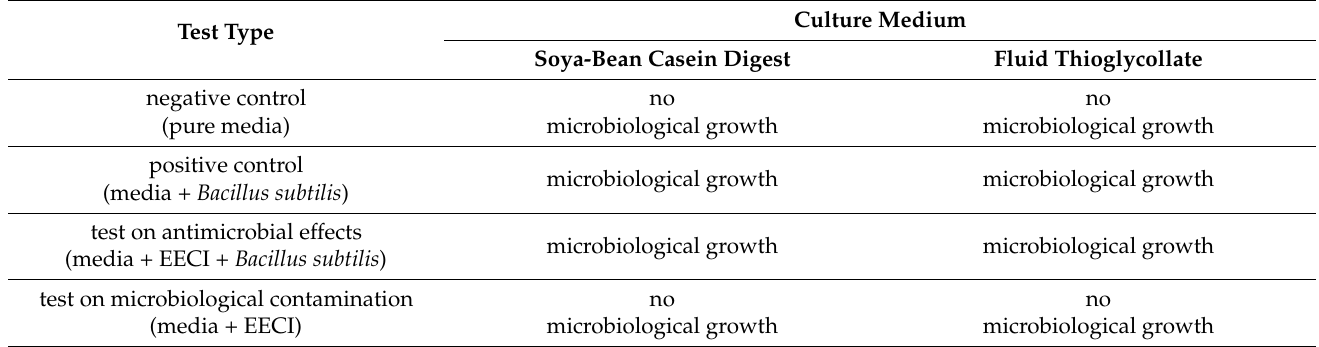
Table 2. Results of the pre-test on microbiological contamination of the 3D-printed EECI after 14 days of incubation in culture medium. Bacterial growth was identified by the formation of turbidity or